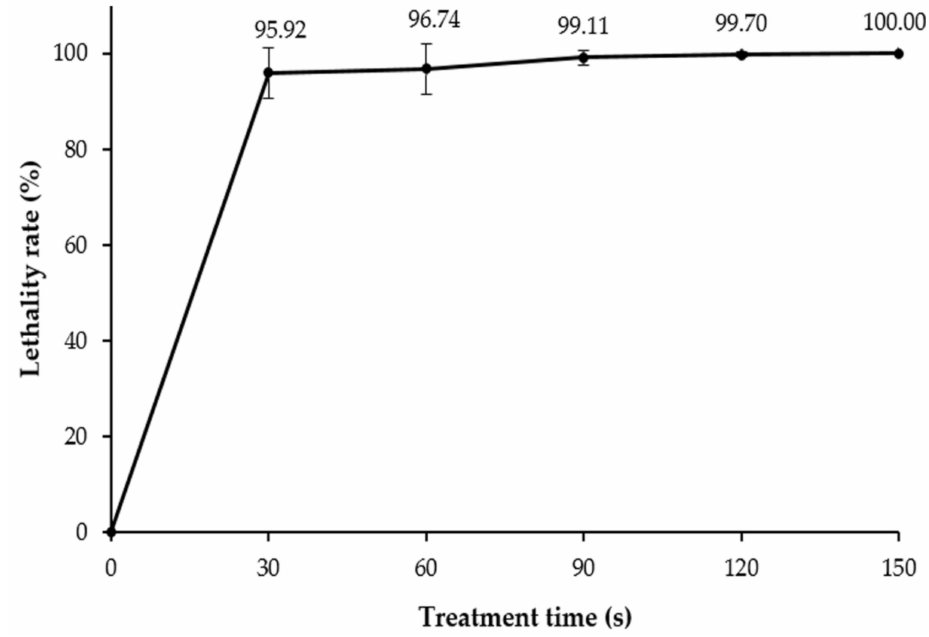
Figure 3. The lethality rate of Brevibacillus sp. SPR19 by ARTP treatment. The experiment was performed in triplicate, and the results were expressed as mean ± SD ( n =